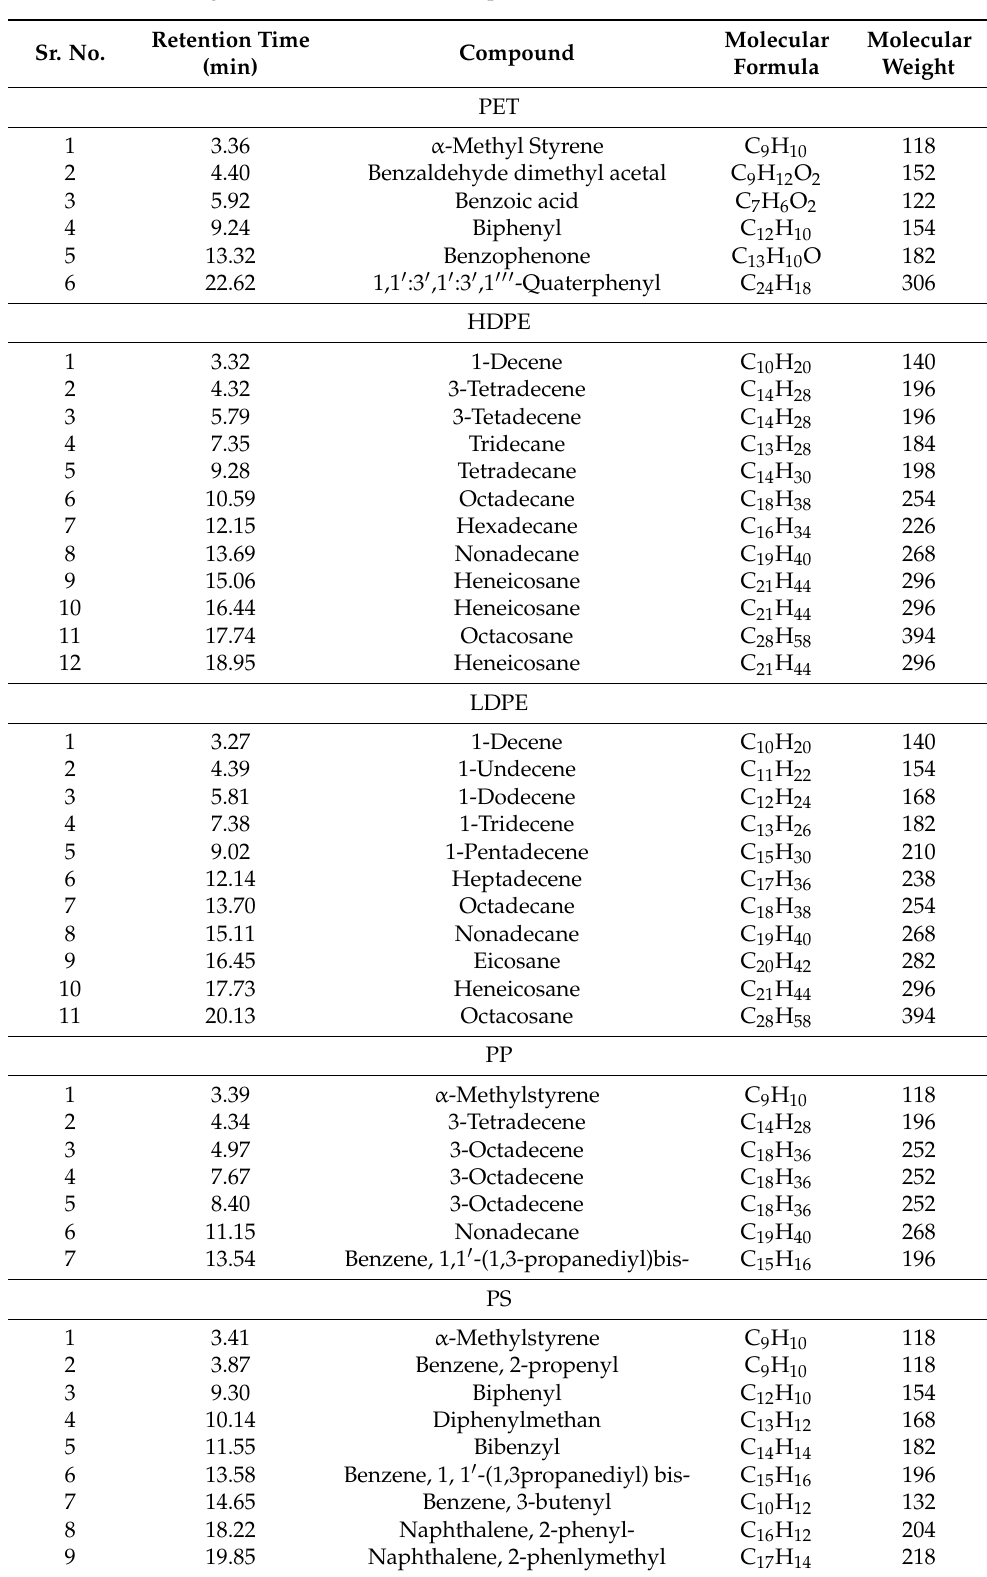
Table 4. GC-MS assignment for the derived fuel